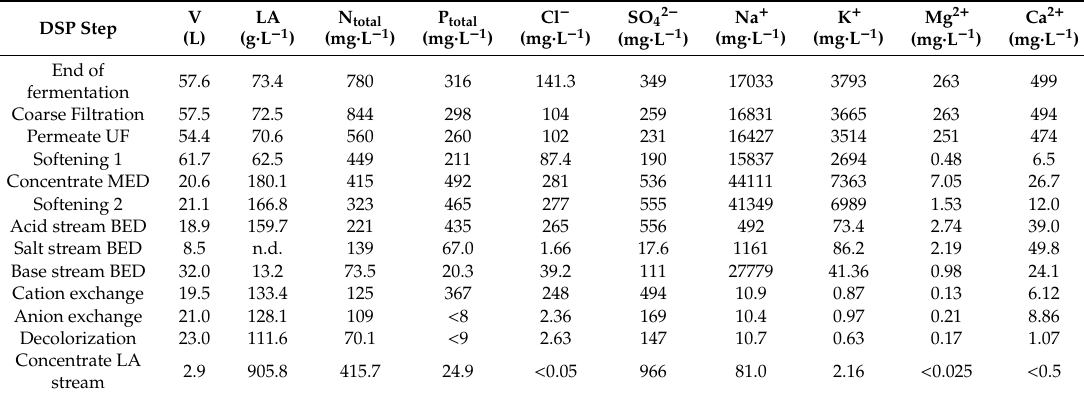
Table 3. Compositional analysis after every step of the downstream process (DSP) of the fermentation broth, obtained from the pilot scale fermentation, using SSJ as a